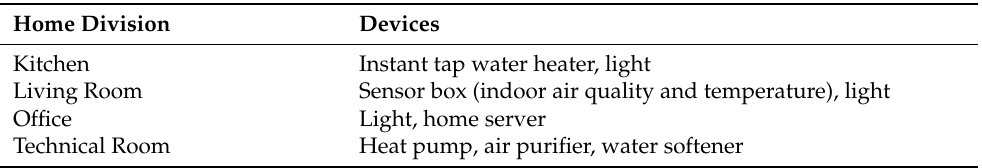
Table 1. Overall context of the smart home’s demonstrator, aimed at a studio apartment with four divisions and several